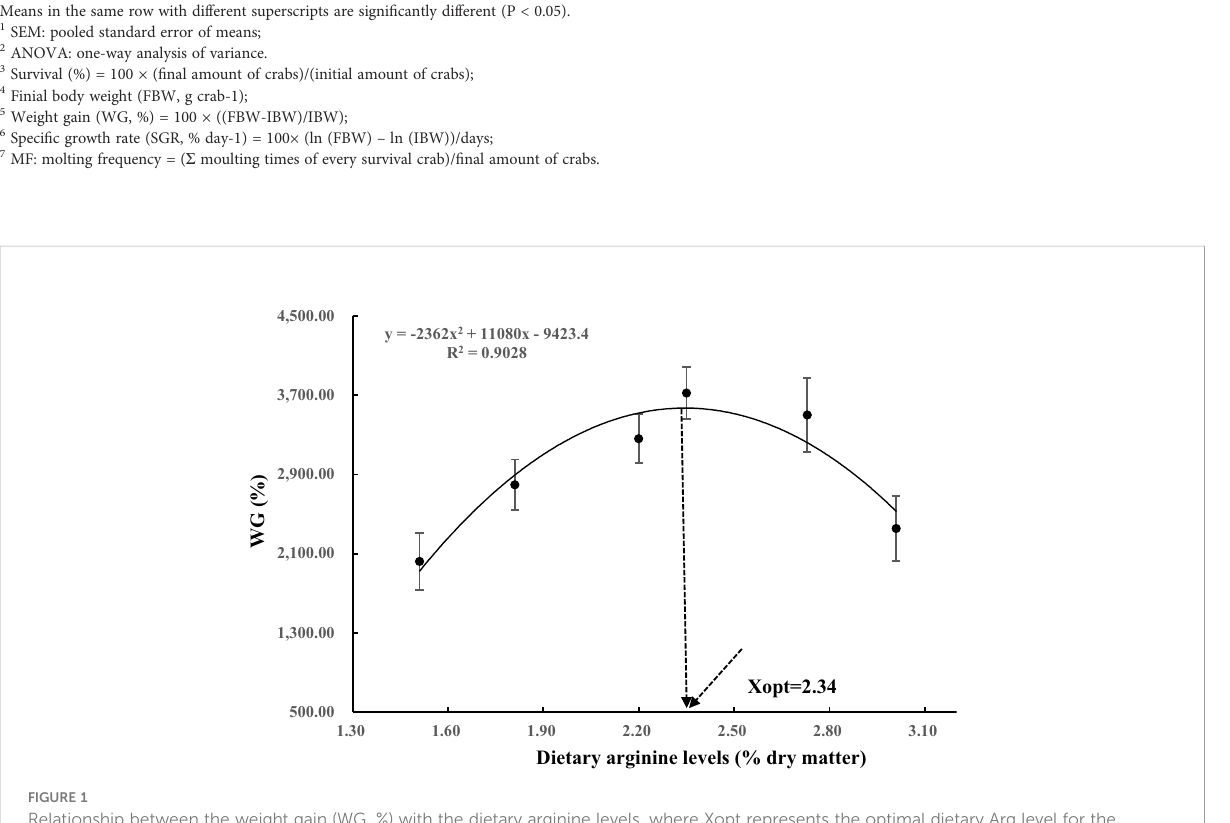
(Figure 1). Dietary Arg levels had no signi fi cant effect on molting frequency (MF; P >0.05).